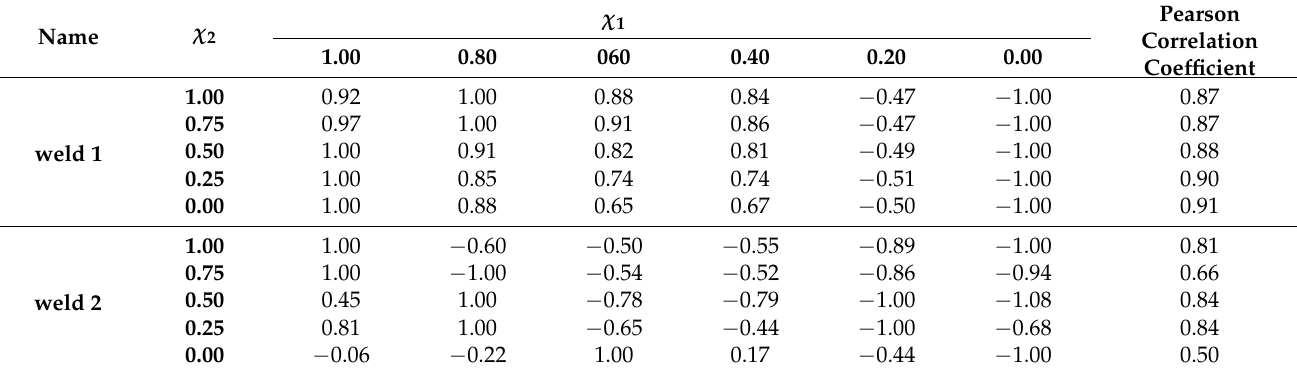
Table 5. The correlation of side column